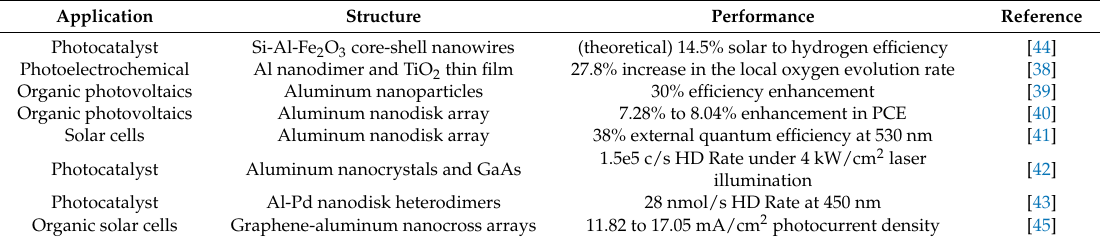
Table 2. Typical energy applications of aluminum as a plasmonic material.